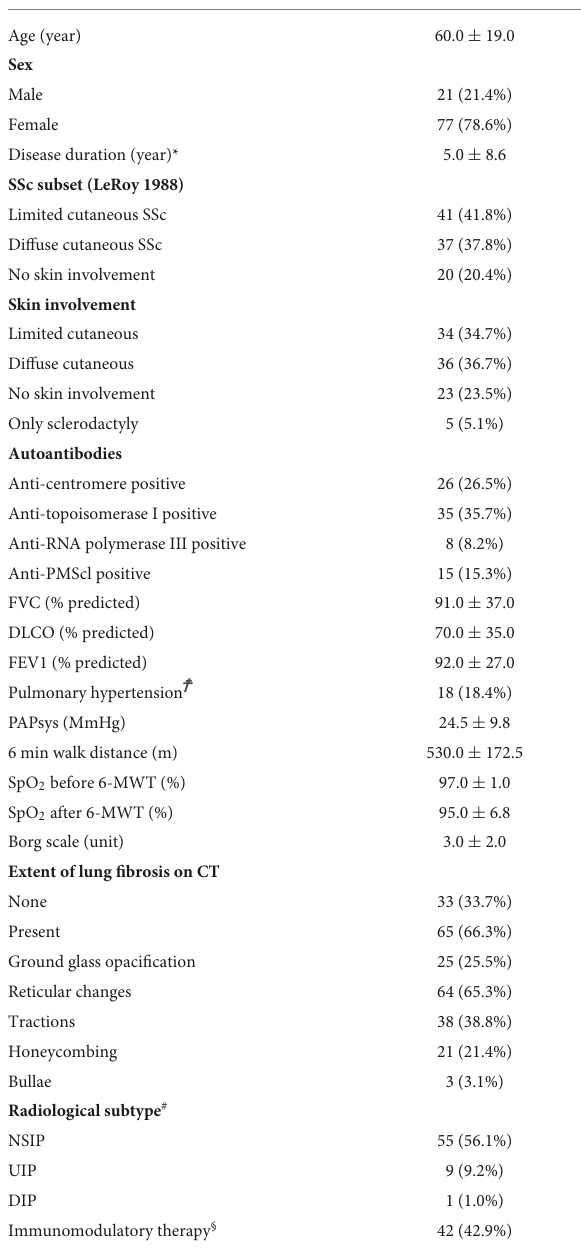
TABLE 1 Summary of patient’s demographics and clinical baseline characteristics.